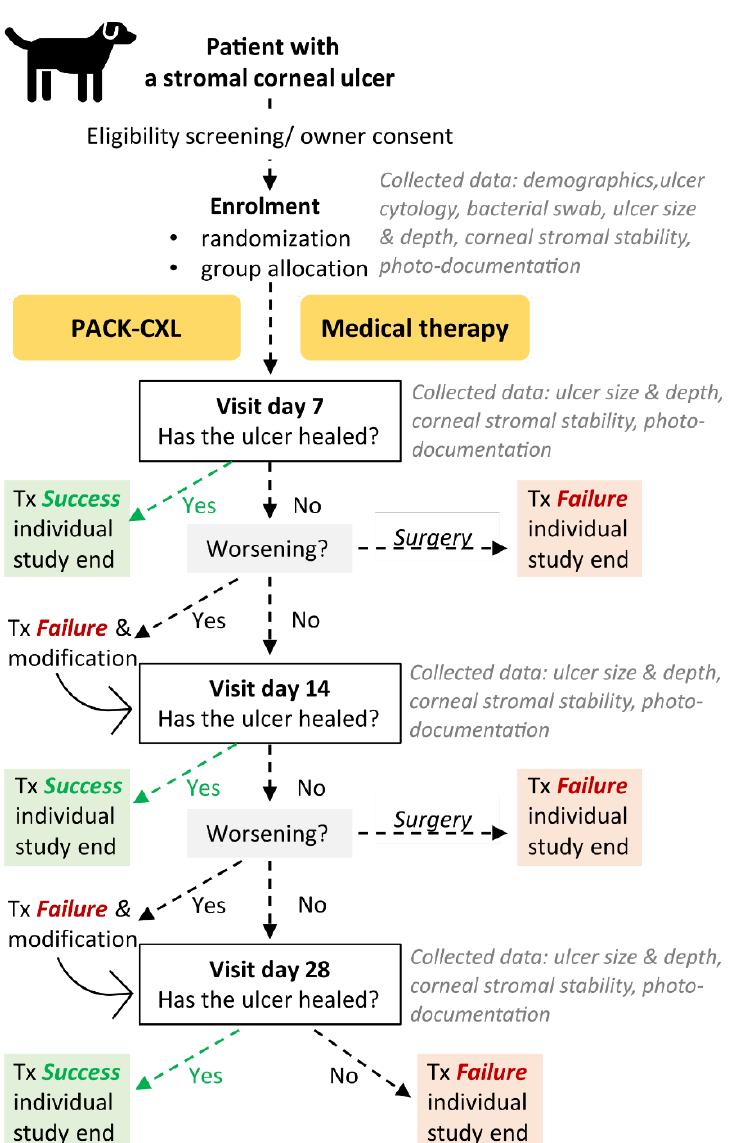
Figure 1. Study flow chart. Tx = treatment.